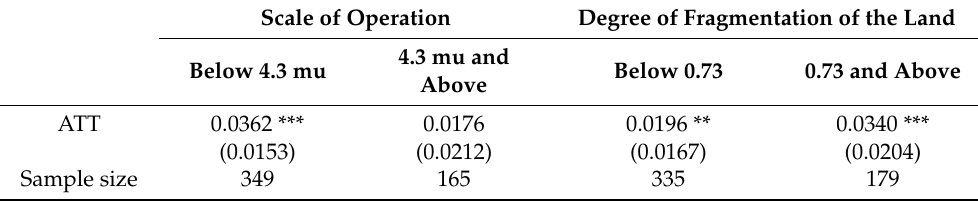
Table 11. Heterogeneity analysis based on land characteristics.